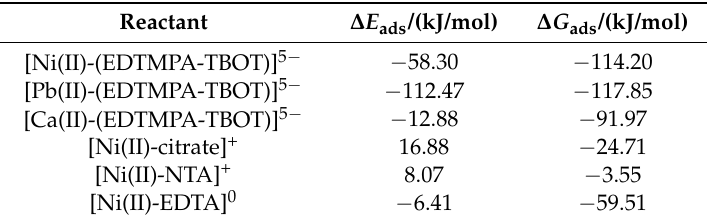
Table 3. Calculated values of ∆ E ads and ∆ G ads for the metal-based complexes.